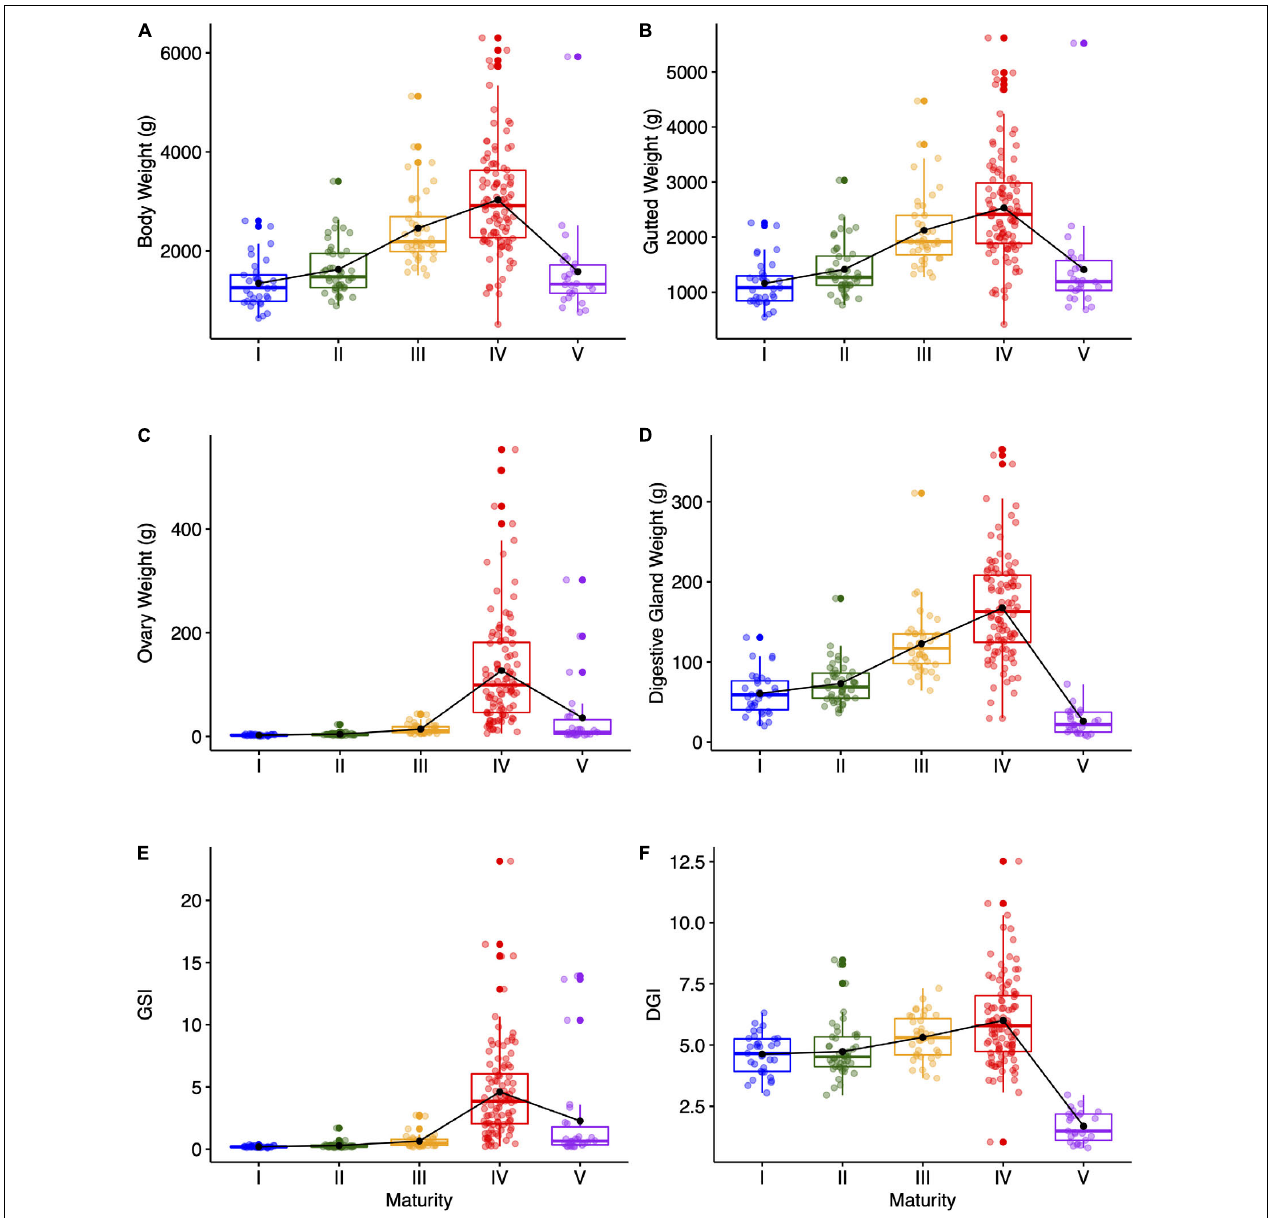
FIGURE 1 | Boxplots showing the distribution of (A) body weight, (B) gutted weight, (C) ovary weight, and (D) digestive gland weight data across maturity stages. Shown are also the patterns in (E) GSI and (F)